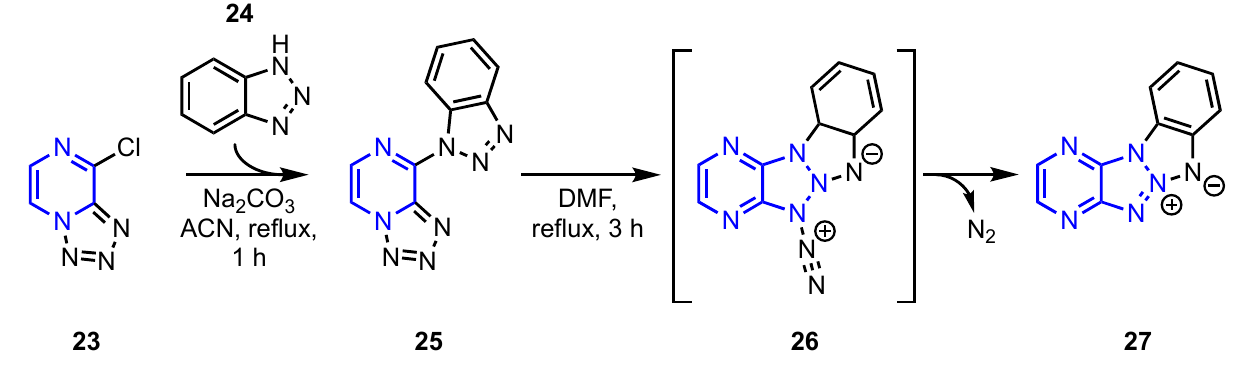
Scheme 4. Synthesis of an azapentalene, 5 H -pyrazino[2 (cid:48) ,3 (cid:48) :4,5][1,2,3]triazolo[1,2- a